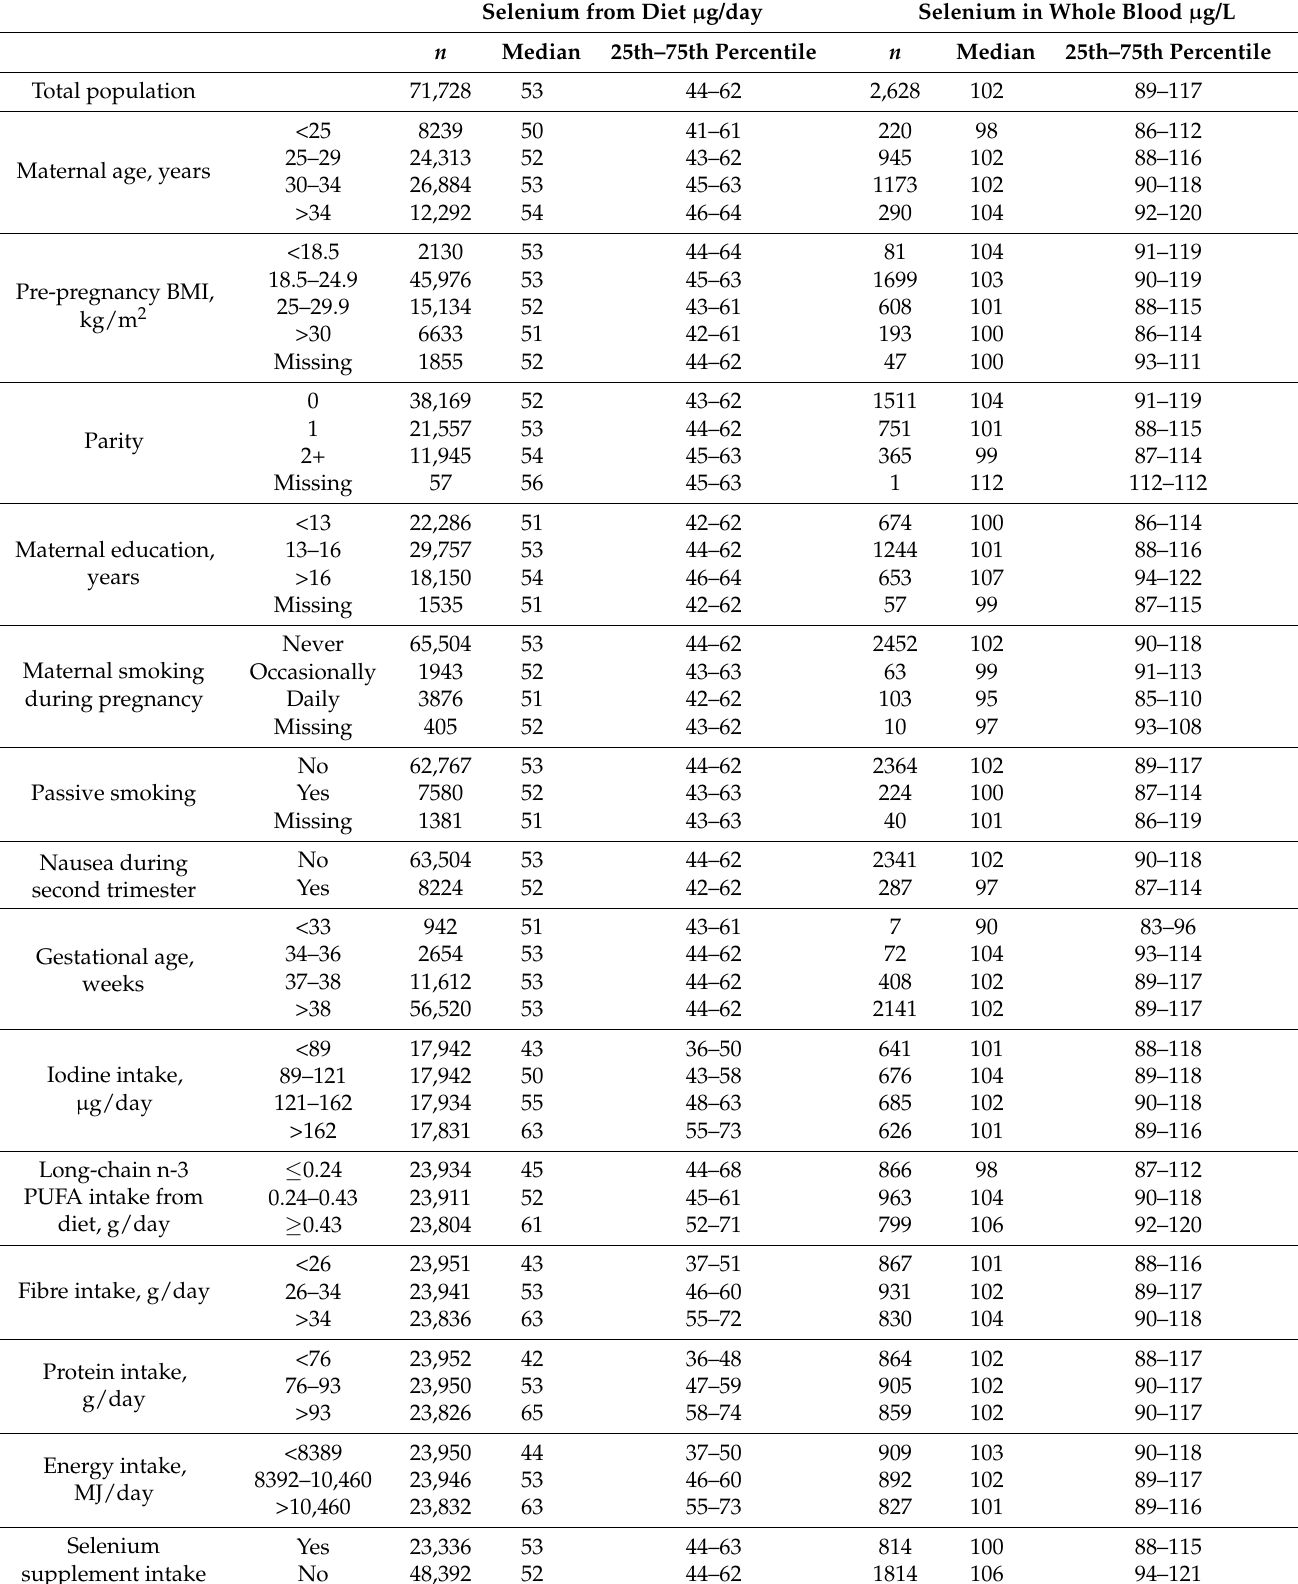
Table 1. Selenium intake and selenium status by maternal